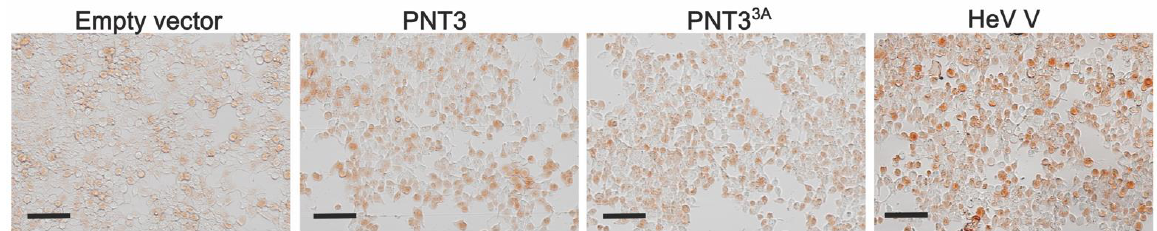
Figure 11. CR-staining of HEK 293T cells transfected with an empty vector or with constructs driving the expression of PNT3 or PNT3 3A , or V at 48 h post transfection. Scale bar: 200 μ m.